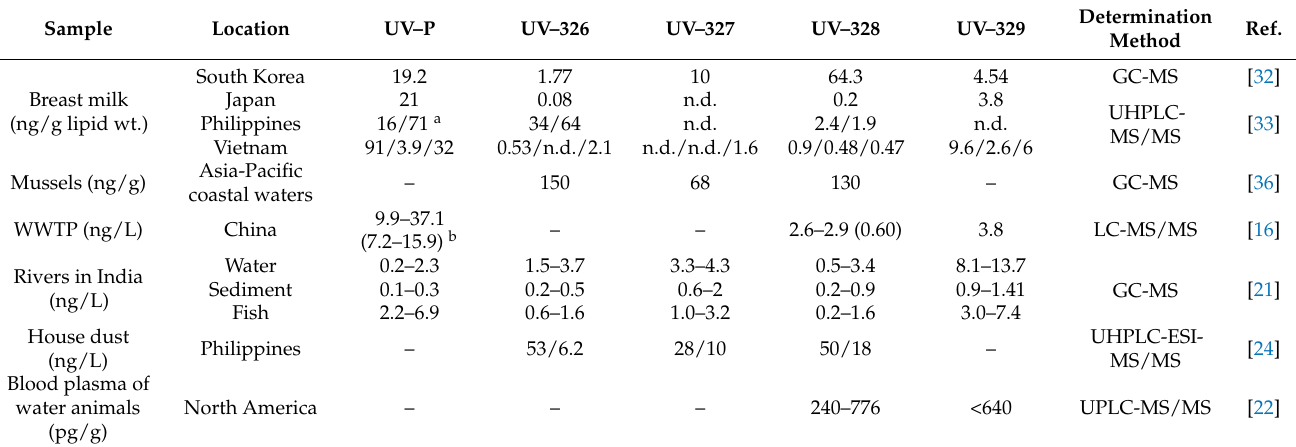
Table 1. Concentration of target benzotriazoles in environmental and biological